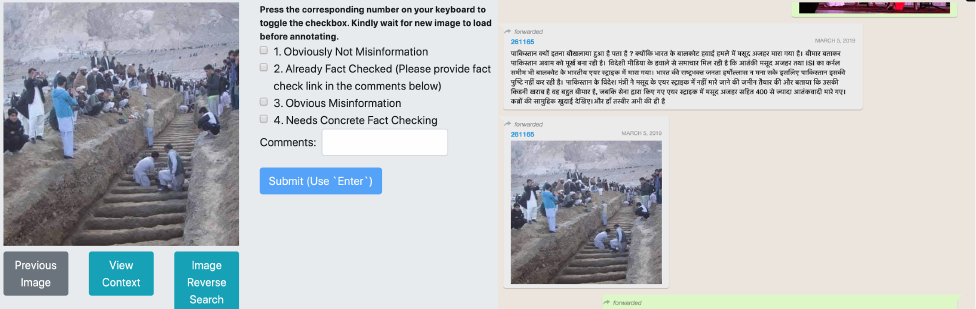
Figure 2. (a) Annotation portal used for annotating misinformation images, (b) Image shown in the chat context in which it was